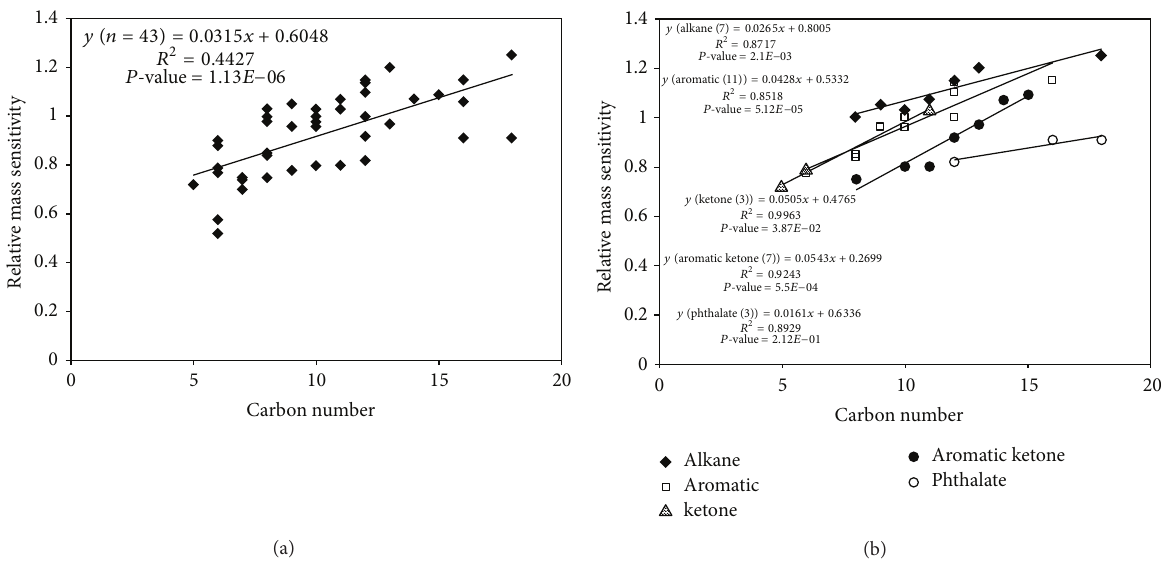
Figure 2: Reinterpretation of the mass sensitivity data by Allgood et al. [12] against carbon number.